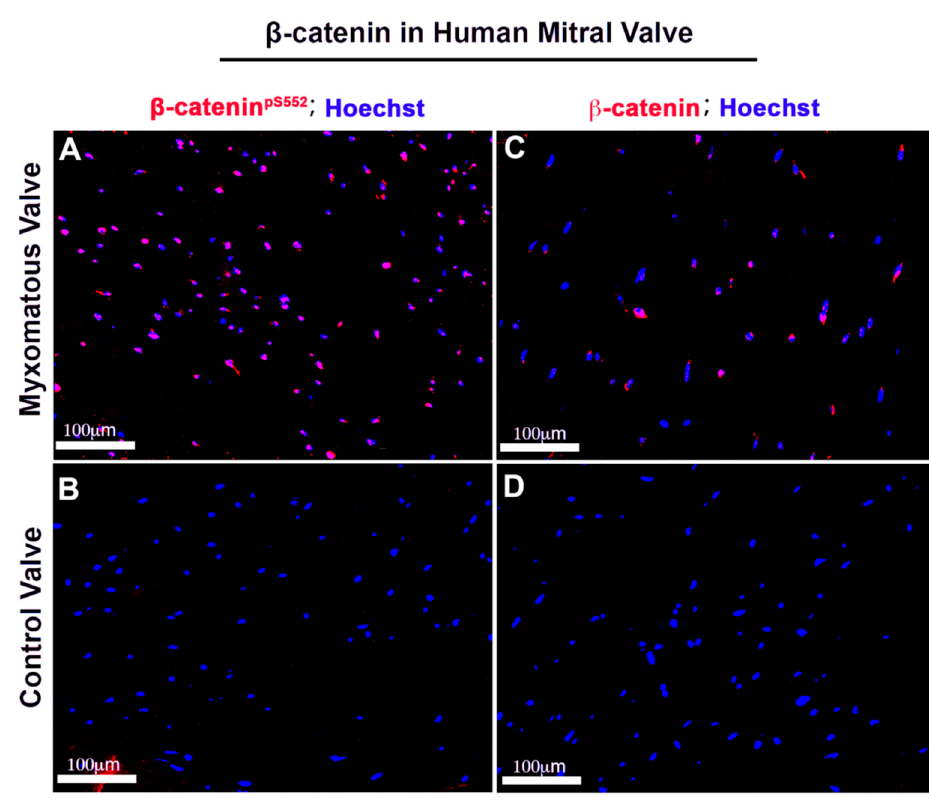
Figure 10. Human myxomatous mitral valves have increased nuclear β -catenin. Human adult myxomatous mitral valve ( A , C ) and control mitral valve tissues ( B , D ) were stained for activated and membrane β -catenin (red). Control adult mitral valve leaflets had undetectable activated or membrane β -catenin expression. Myxomatous valve tissue had increased activated and non-phosphorylated β -catenin compared to the control.